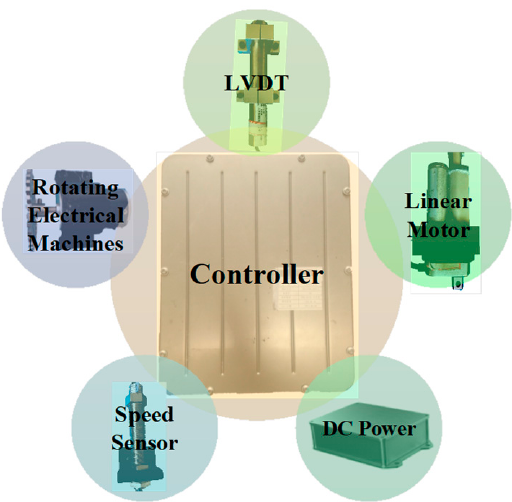
Figure 4. The composition of the aero-engine fuel control system.